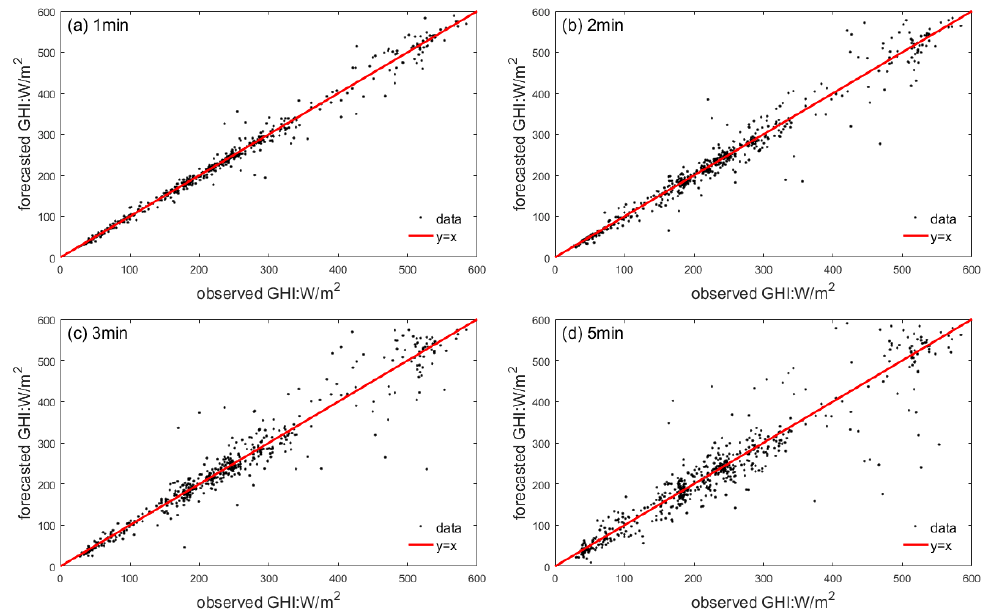
Figure 12. Scatter plots of GHI forecasting based on the BPN model for 1 min ( a ), 2 min ( b ), 3 min ( c ), 5 min ( d ) on 5 November 2017.